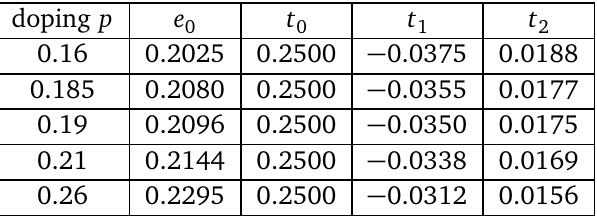
Sr CuO from Lee-Hone et al. [ 73 x 2 − x 4